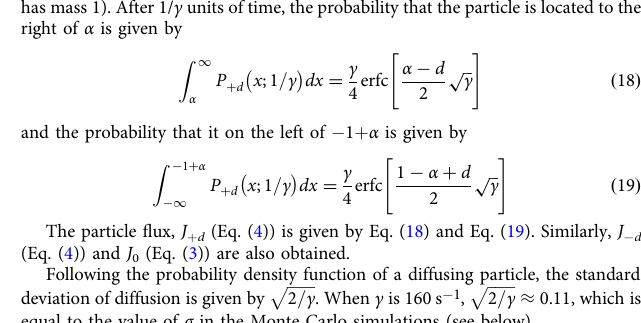
equal to the value of σ in the Monte Carlo simulations (see